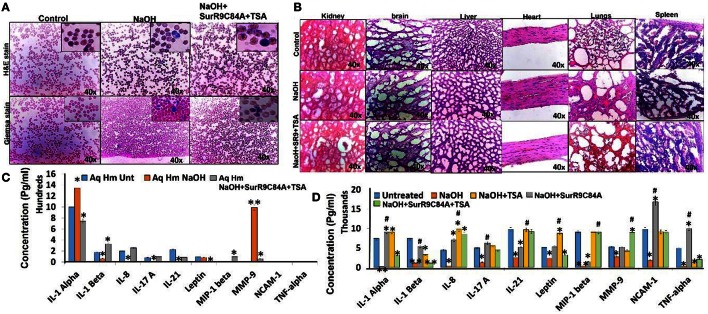
Identifying the cytokines involved in alkali burn. (A) The H & E stain revealed the appearance of neutrophils with NaOH insults which is a common sign of inflammation initiation. (B) The histological analysis was performed in kidney, brain, liver, heart, lungs, and spleen tissues obtained from untreated, NaOH treatment and NaOH+SurR9-C84A+TSA treatments. No visible signs of toxicity or tissue damage were observed among all the treatments as they resembled the control tissues in terms of morphology. (C) The cytokine array analysis was performed for the aqueous humor in the control, NaOH, NaOH/TSA+SurR9-C84A, TSA alone and SurR9-C84A alone groups. It was observed that NaOH treatments led to an increase in the IL-1α and MMP-9 levels, while TSA+SurR9-C84A treated cornea showed comparatively lower levels of IL-1α and MMP-9. (D) In case of the corneal lysates, TSA did not influence the expression of IL-1α, IL-21, MIP-1 beta, and NCAM-1. SurR9-C84A led to an increase in expression of NCAM-1 and TNF-alpha. Data represents mean ± SEM. Experiments were repeated 3 times in triplicates. Representative images have been presented. **P < 0.01; *P < 0.05; treatment vs. control, #Most effective treatment.